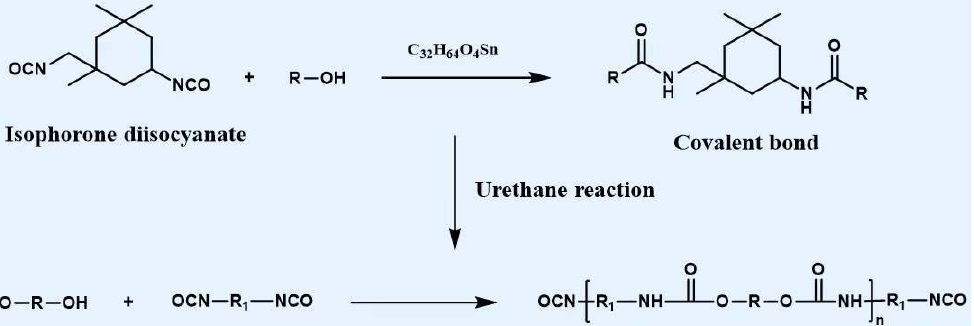
Figure 6. Reaction mechanism of connecting lignin and cellulose via covalent bonds (adapted from Ref. [81]).